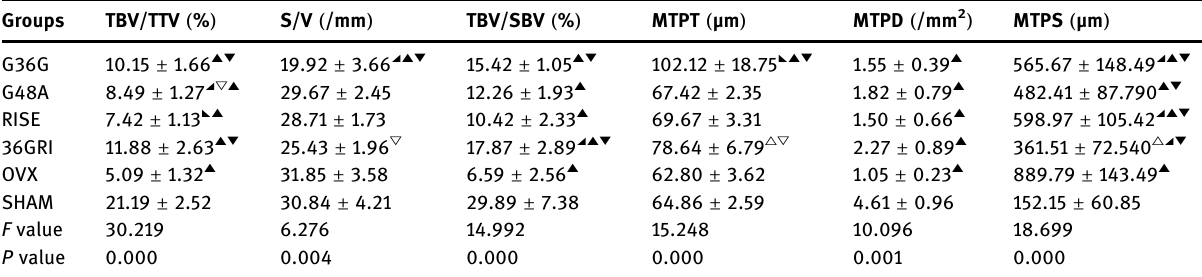
Table 6: E ff ects of di ff erent interventions on the morphological parameters of tibial epiphysis ( x s ¯ ± )